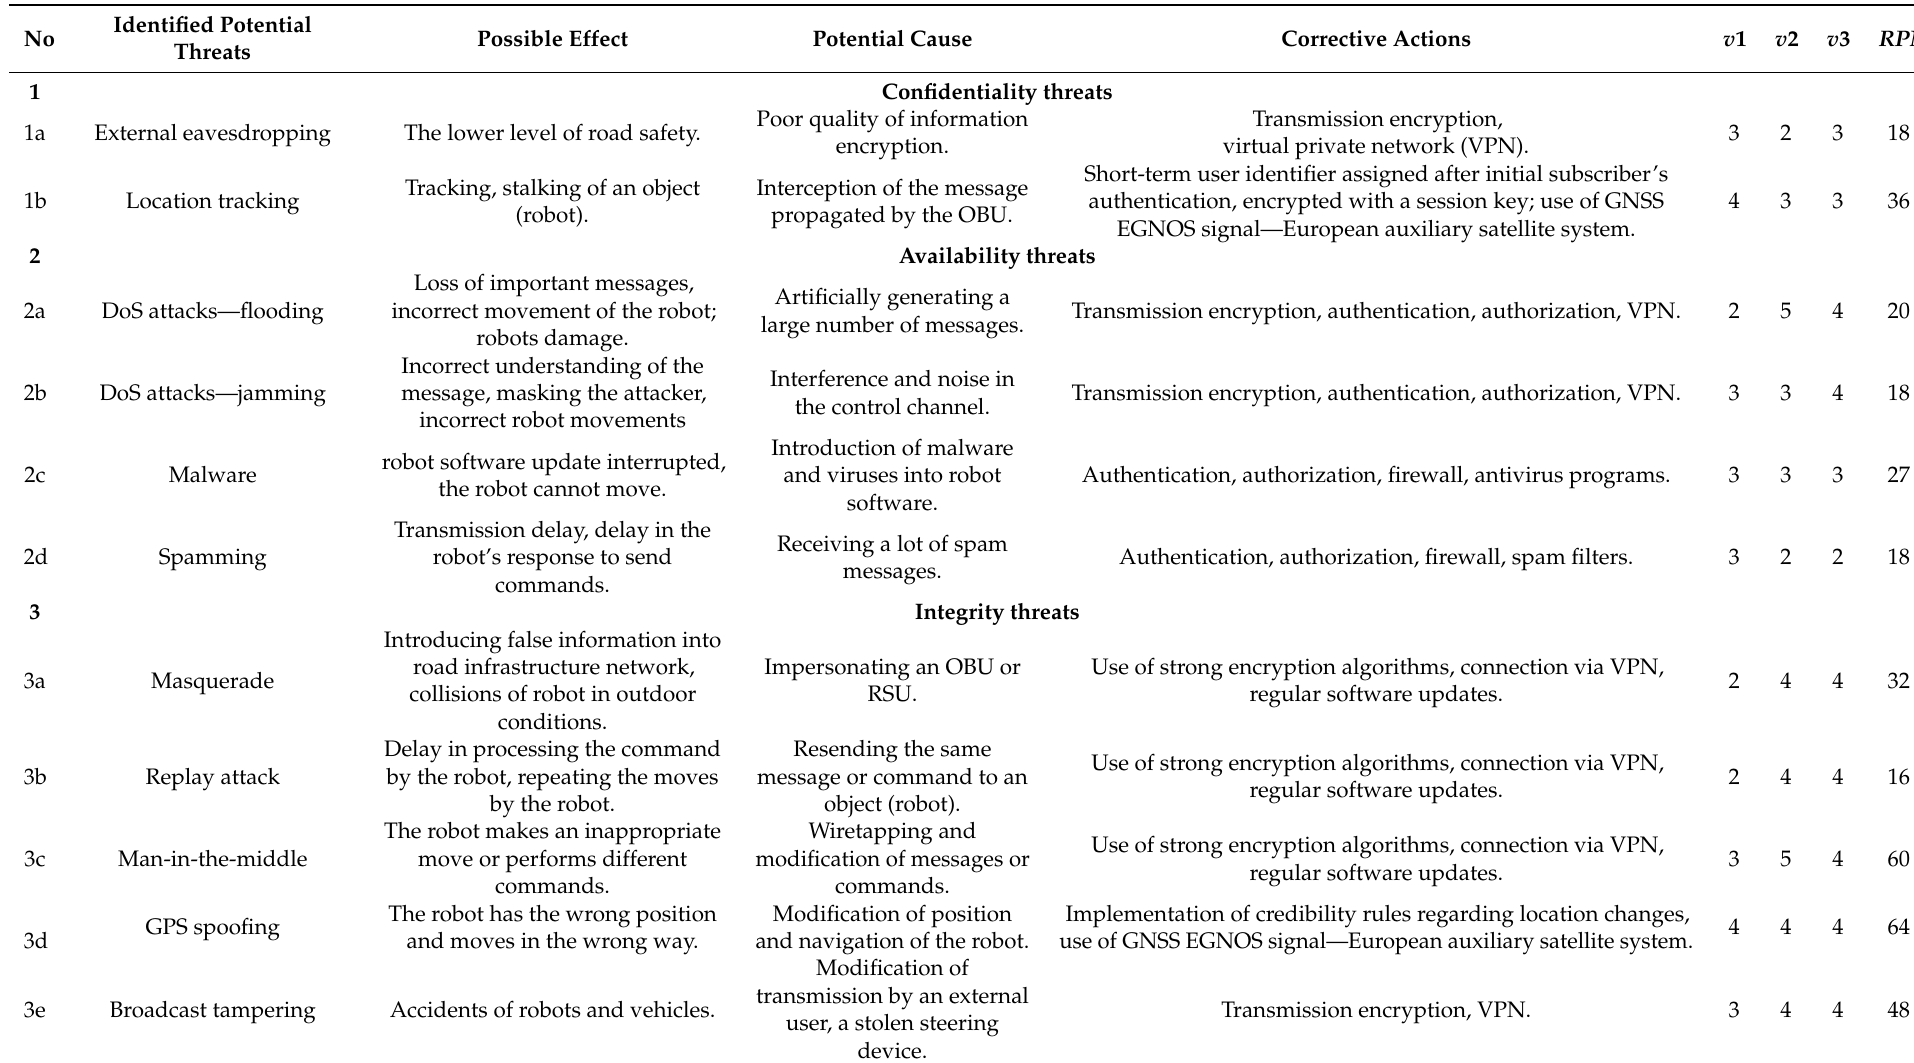
Table 3. FMEA risk analysis in the R2I model, own